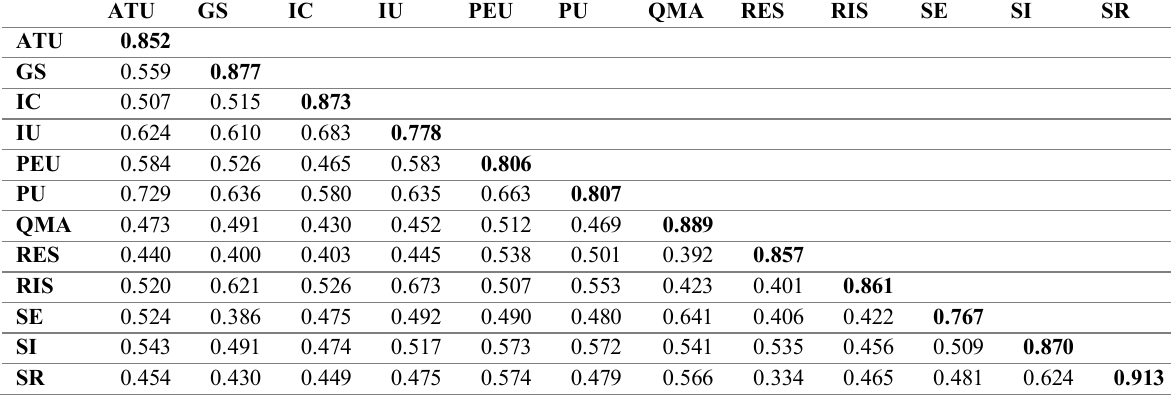
Table 3: Discriminant Validity (Fornell-Larcker